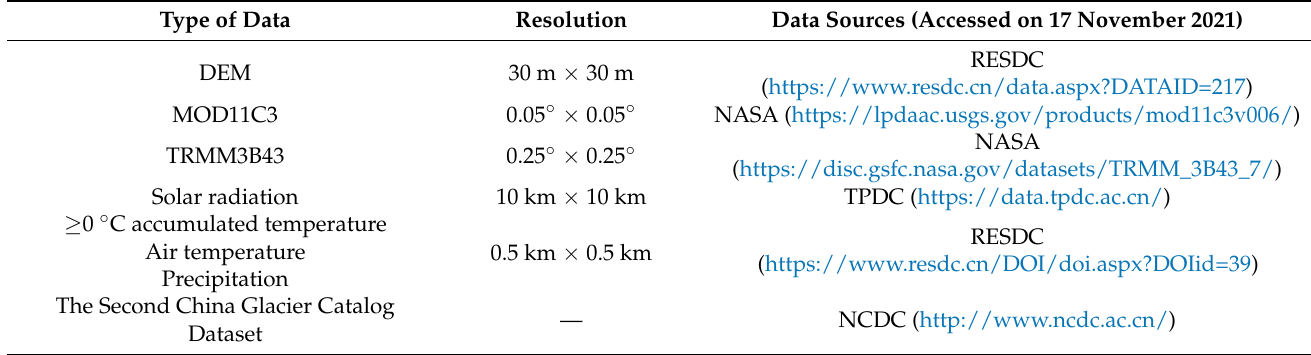
Table 1. Data Table 1. Data sources.